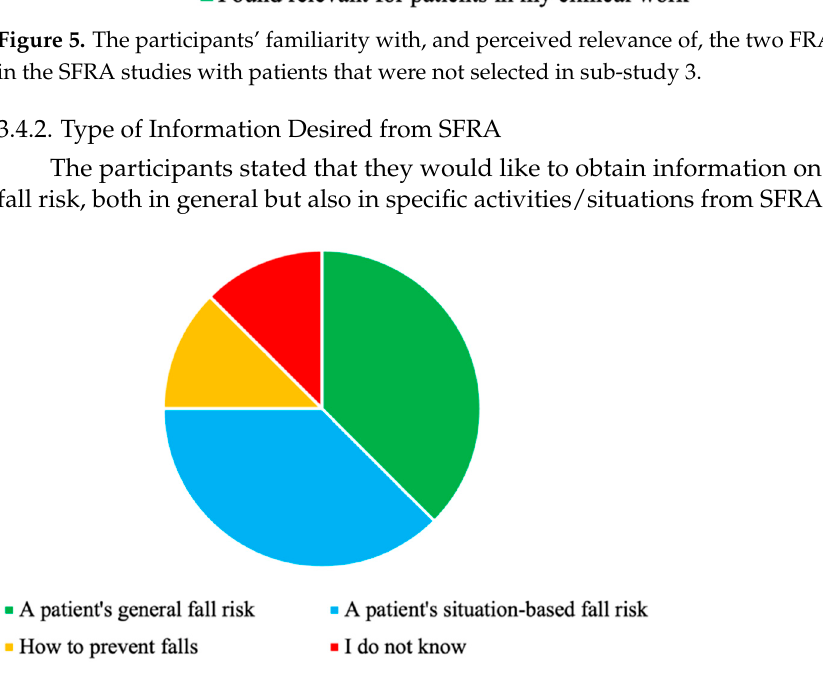
Figure 6. Information that the participants would like to obtain from SFRA (N = 8).